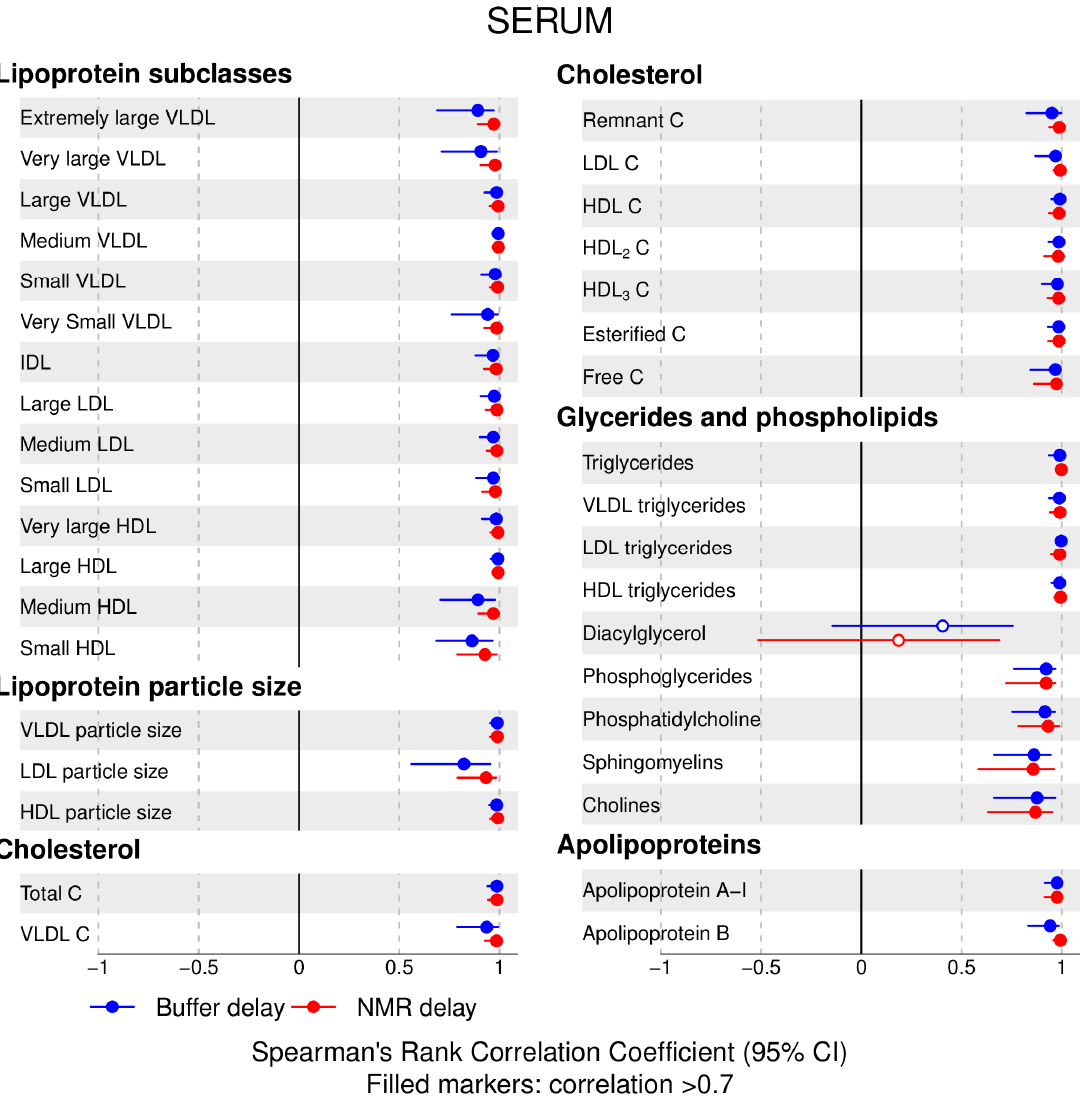
Figure 5. Serum, post-storage handling effects: Spearman’s rank correlation coefficients between metabolic trait concentration/value in reference samples (no buffer addition or nuclear magnetic resonance (NMR) analysis delays) and samples subjected to two variant post-storage conditions in which samples thawed overnight and afterwards (i) were left for 24 h before addition of sodium buffer followed by immediate NMR analysis (buffer delay); and (ii) addition of sodium buffer, then left for 24 h before profiling (NMR delay) (correlations for lipoprotein trait details are given in Figure S3, Supplementary Materials). Spearman’s rank correlation coefficients and 95% confidence intervals (CIs) are listed in Table S4, Supplementary Materials. C, cholesterol; IDL, intermediate-density lipoprotein; LDL, low-density lipoprotein; HDL, high-density lipoprotein; VLDL, very low-density lipoprotein.